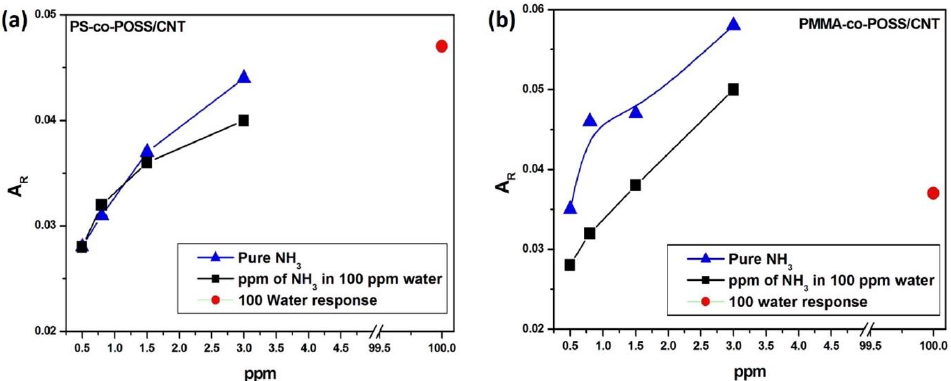
Figure 7. Summary of the effect of the presence of 100 ppm of water on the chemo-resistive responses of ( a ) PS-co-POSS/CNT and ( b ) PMMA-co-POSS/CNT when exposed to NH 3 .